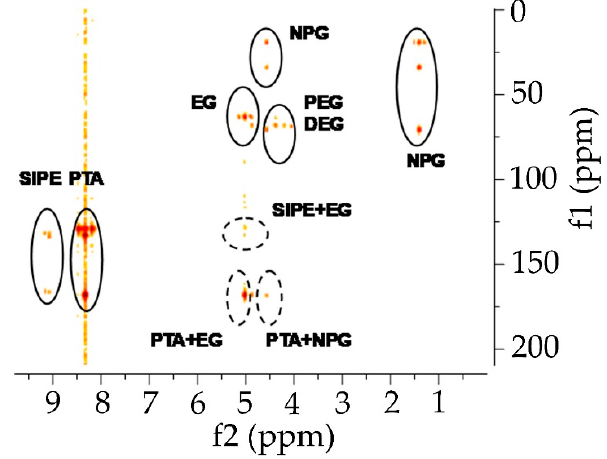
Figure 3. The 1 H- 13 C heteronuclear shift correlation spectrum (HETCOR) of ENCDP-0.